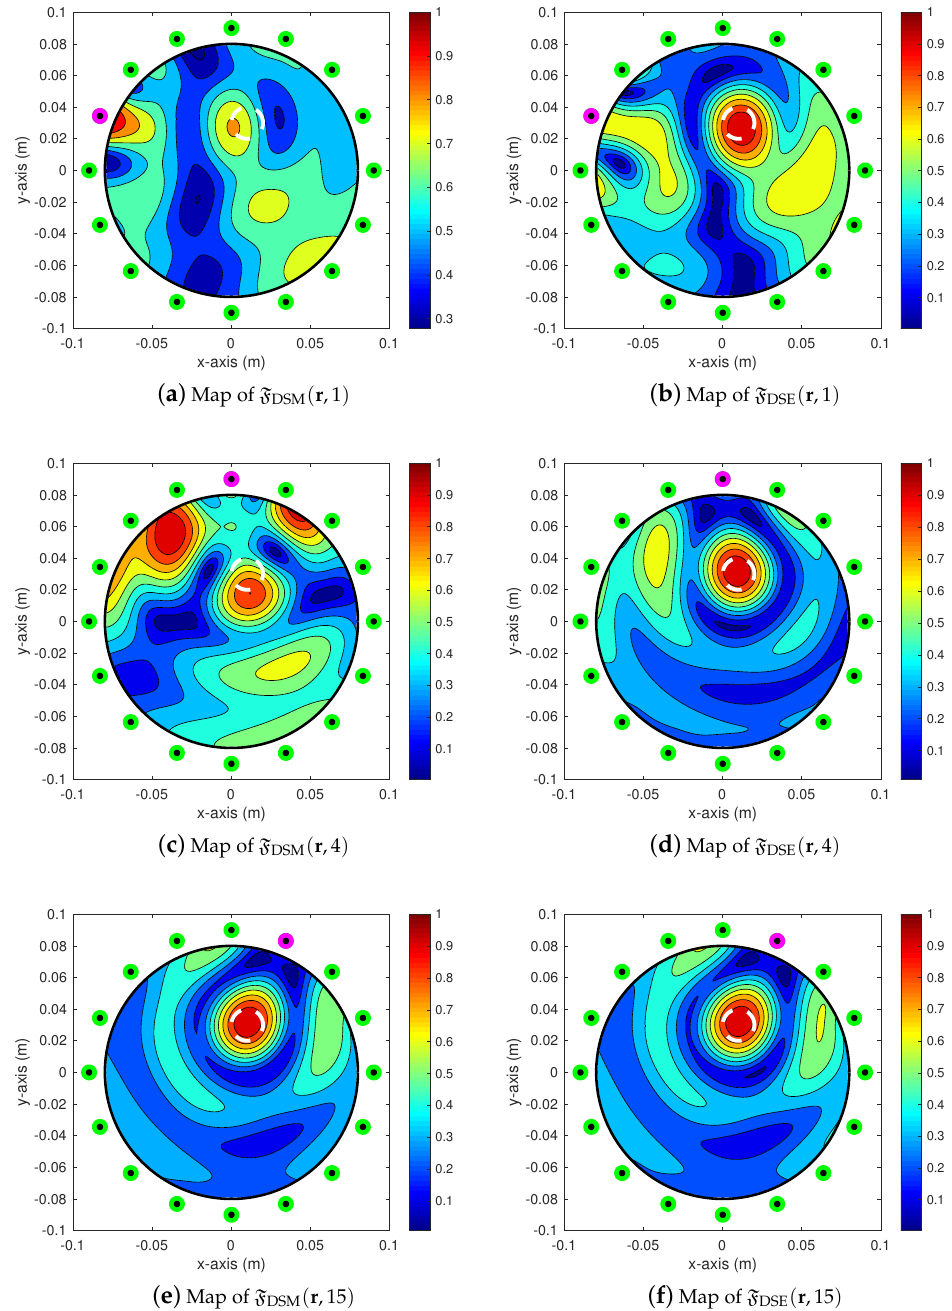
Figure 4. Maps of F DSM ( r , m ) and F DSE ( r , m ) at f = 0.750GHz. White-colored dashed line describes the ∂ D